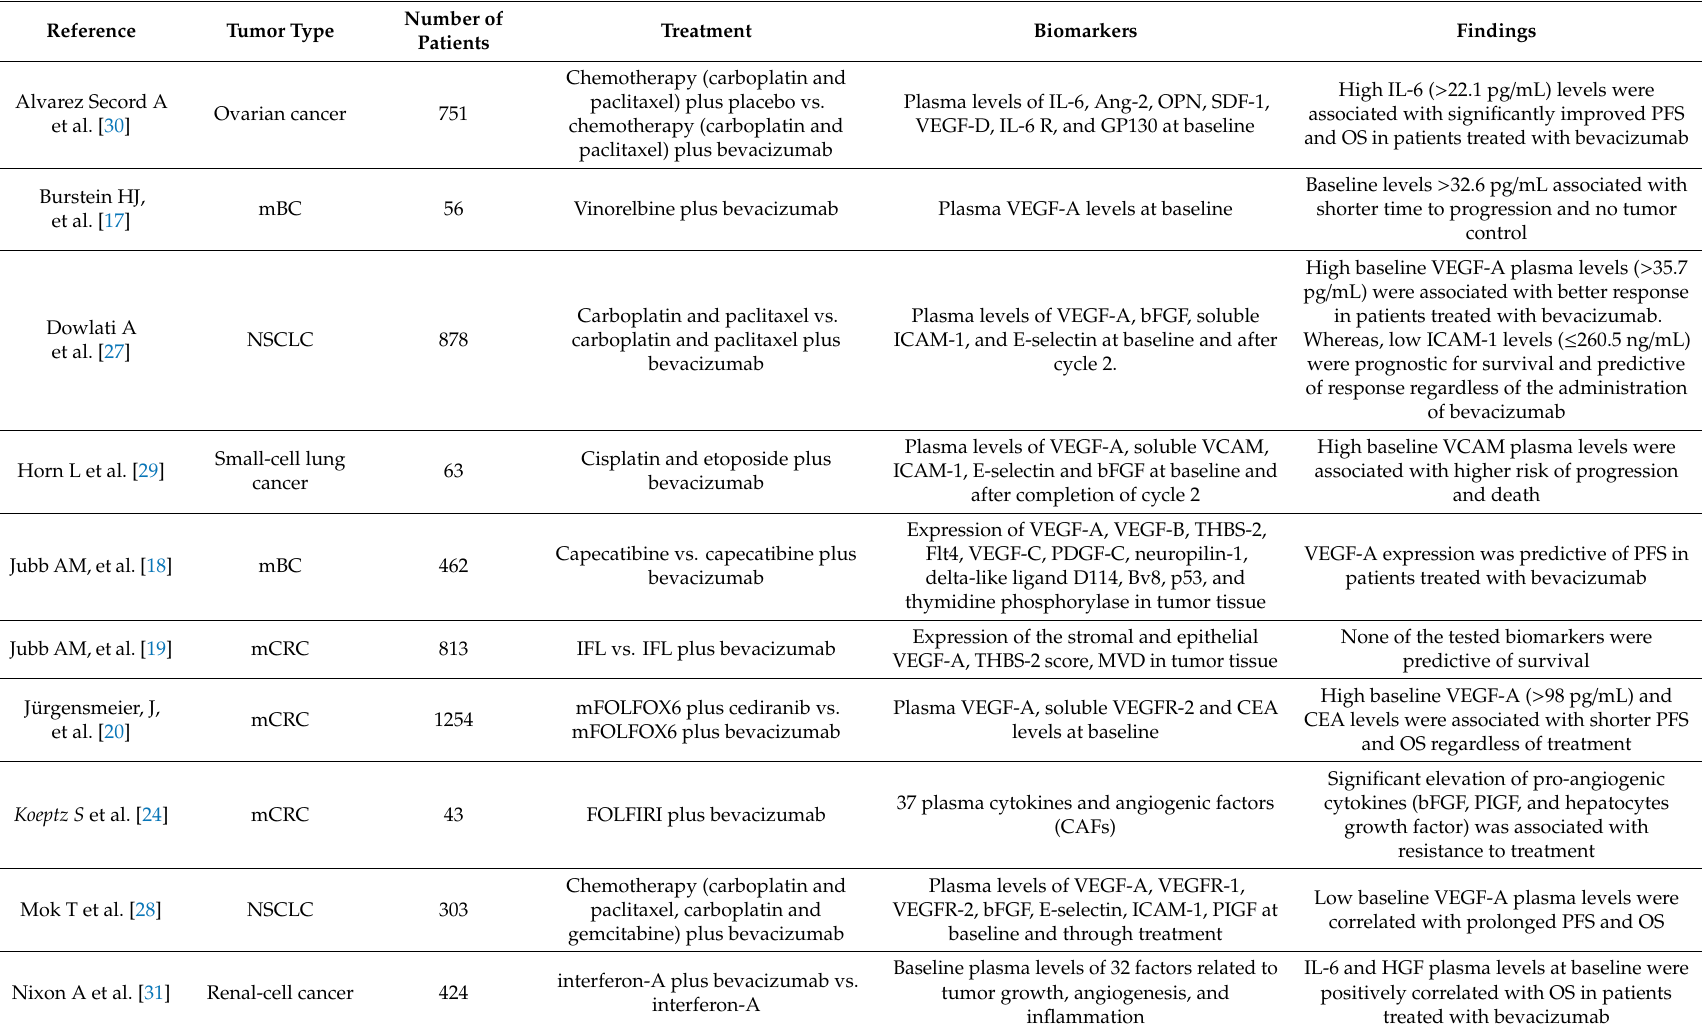
Table 1. Available studies on proteinic biomarkers associated with response to